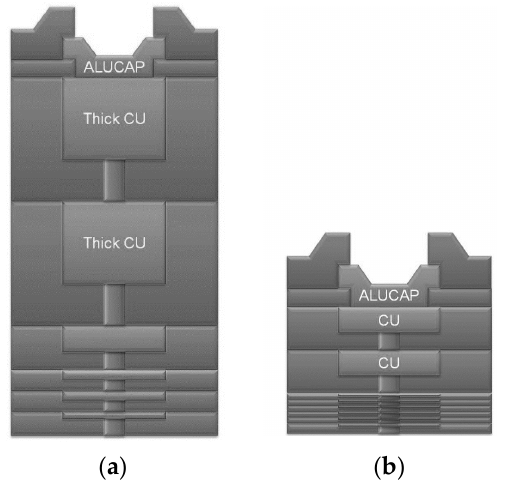
Figure 3. BEOL comparison between ( a ) mm-wave-optimized BiCMOS technology [17] and ( b ) 28-nm CMOS technology with standard BEOL [2], Reprinted from ref. [18] .